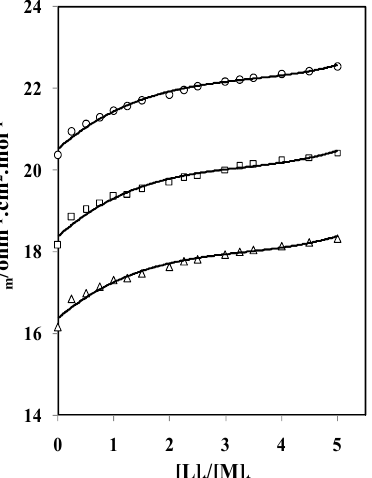
Figure 2. Molar conductance-mole ratio plots for ( p -isopropylcalix[6]arene·Cs) + complexes in DMSO-AN binary system (mol% DMSO = 15.5) at different temperatures ( ∆ = 25 ° C, □ = 35 ° C, ○ =